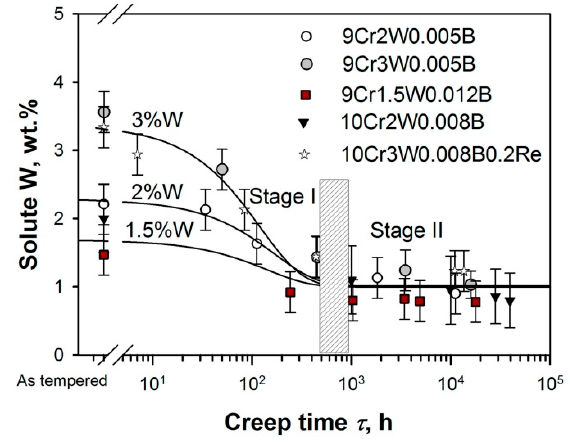
Figure 6. The depletion of W from the solid solution for the steels studied.